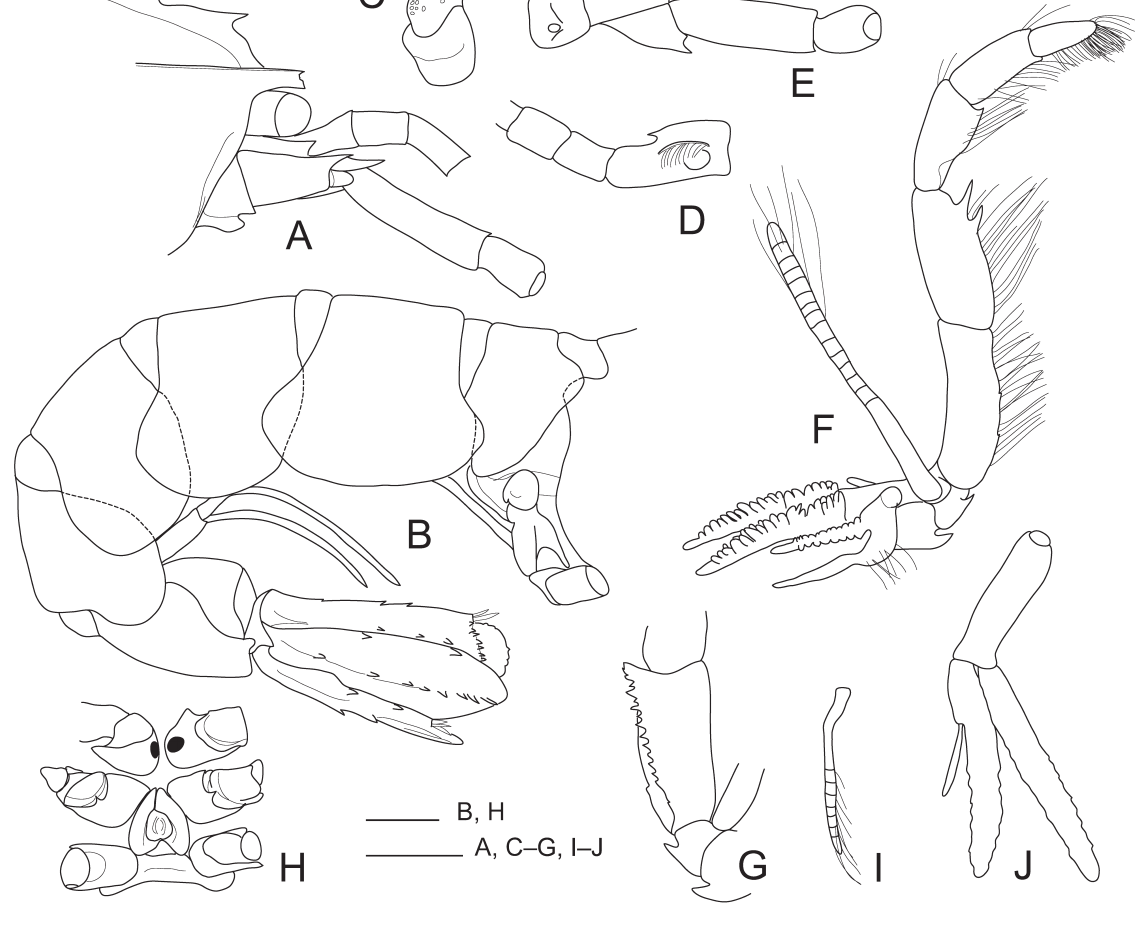
Fig. 2. Montanaxius mediumquod gen. et sp. nov., paratype, ♀, NHMW 25675. A . Front in lateral view (rostrum broken). B . Pleon in lateral view. C . Left eyestalk, dorsal view. D . Right antennule in mesial view. E . Right antenna in ventral view. F . Third maxilliped in lateral view. G . Same in mesial view. H . Sternites 6–8. I . Left first pleopod in lateral view. J . Right second pleopod in posterior view. All setation omitted except in F and I. Scale bars: